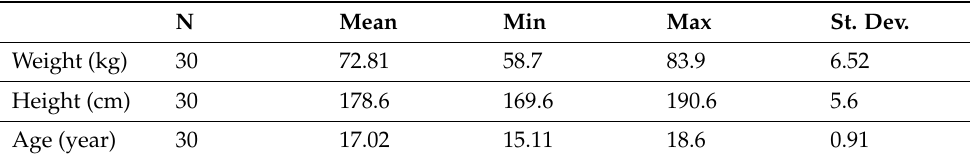
Table 1. Basic descriptive statistics of the participants (n = 30).